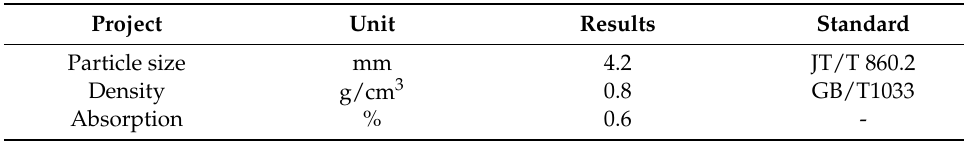
Table 2. Technical specification of TPS high-viscosity